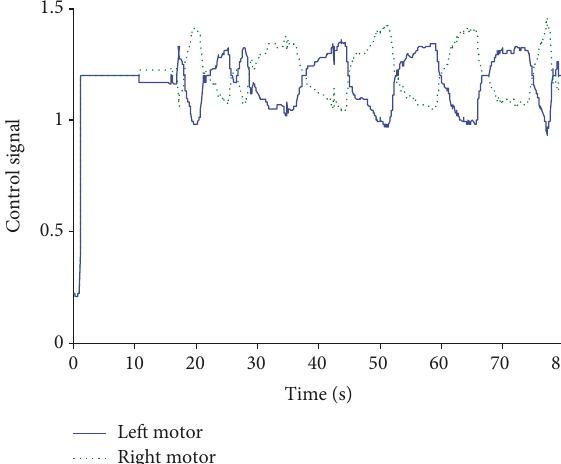
Figure 25: The control signal of in-wheel